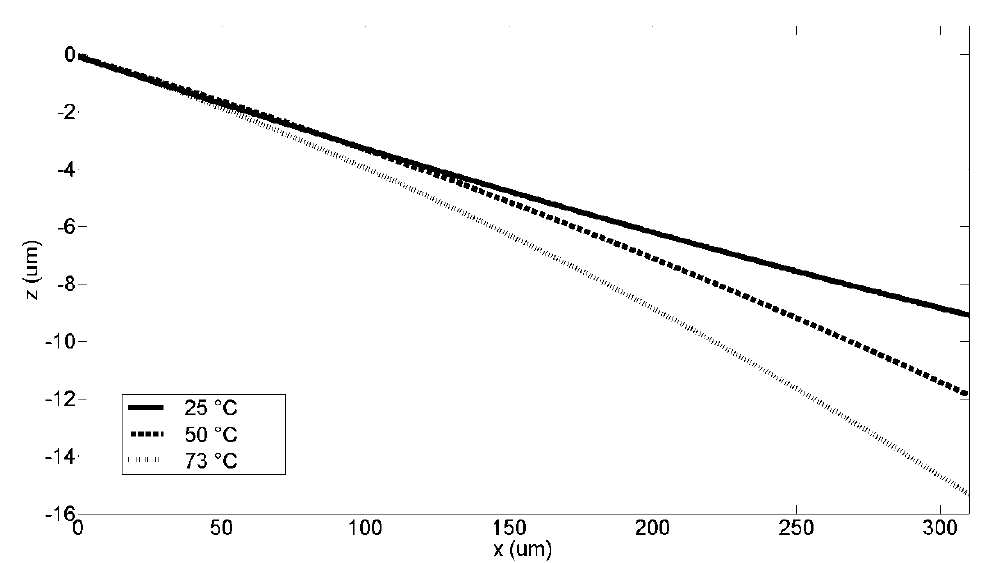
Figure 15. Quadratic fitted surface profiles of a sensing finger extracted from the original Veeco data at 25, 50 and 73 °C,